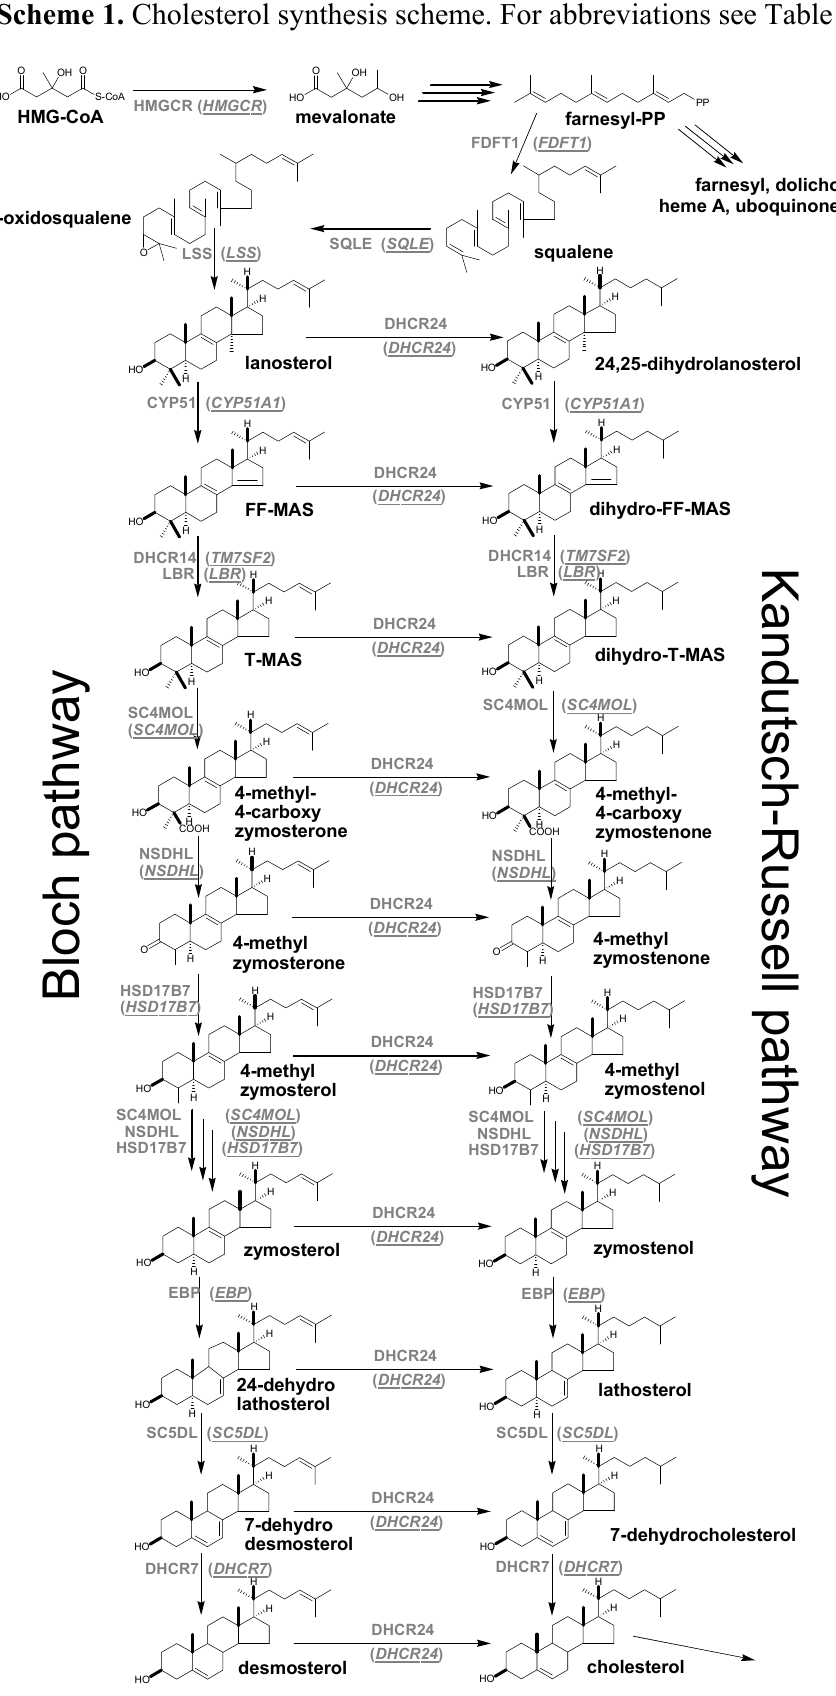
Scheme 1. Cholesterol synthesis scheme. For abbreviations see Table